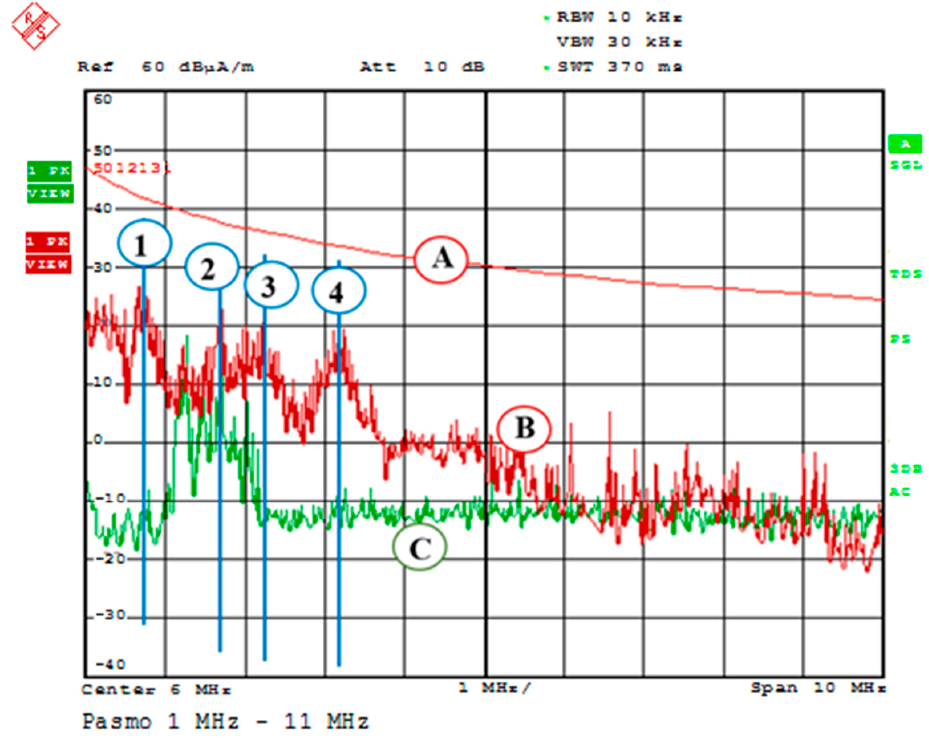
Figure 10. Spectrum of interfering signals radiated by a rail vehicle travelling at a speed of 50 km/h and the electromagnetic background for a frequency range of 1 MHz–11 MHz.